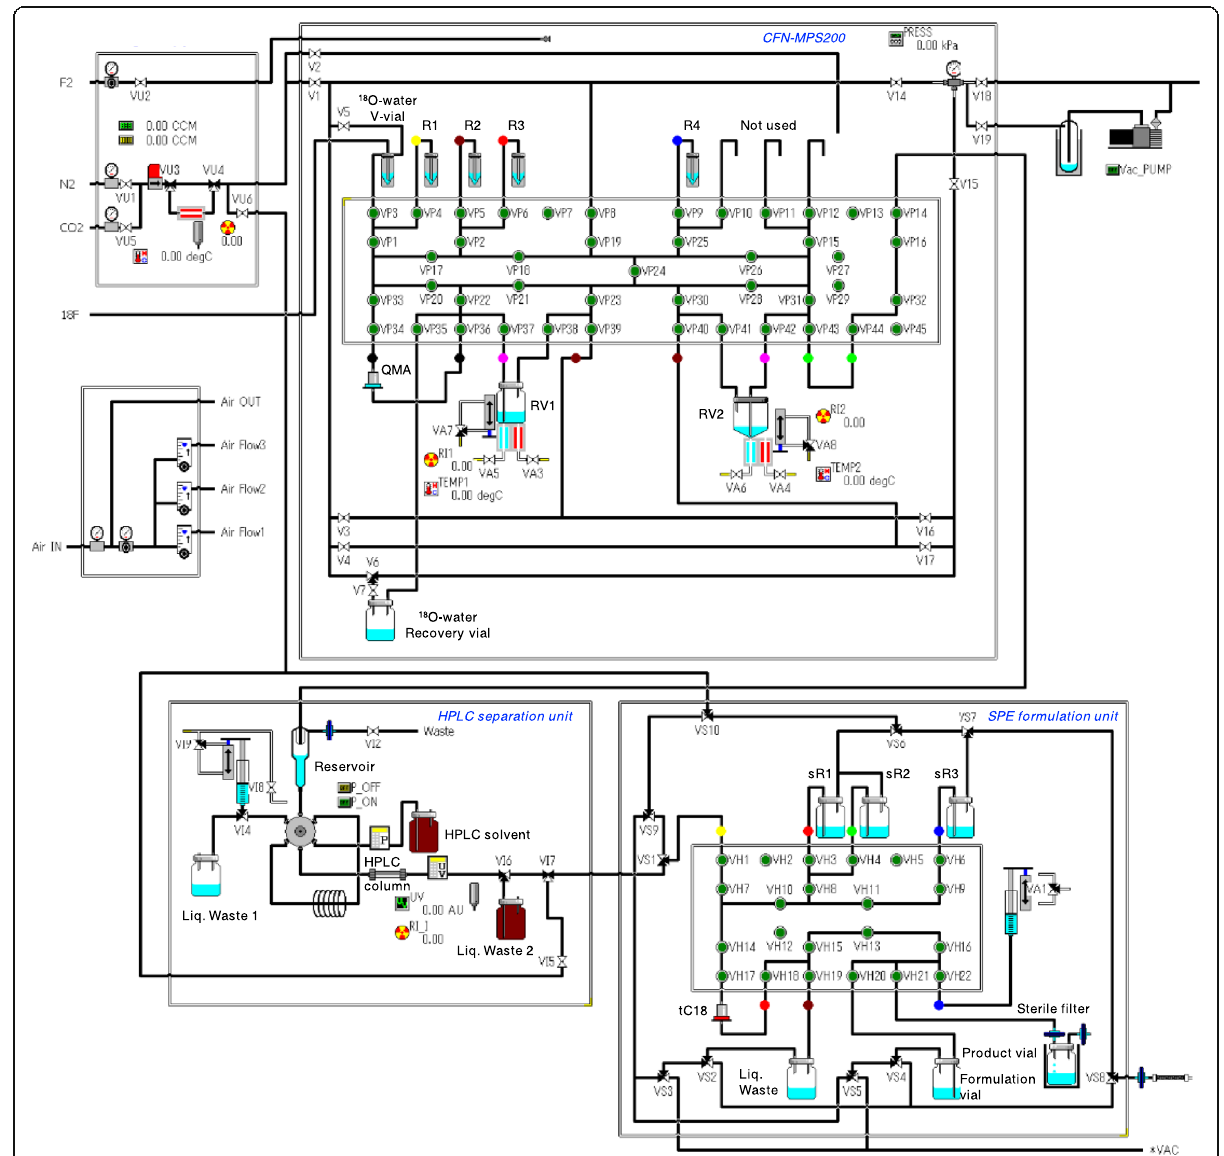
Fig. 1 Setup of the synthesis cassette, reagents, and vials for [ 18 F]MC225 production with integrated HPLC separation and SPE formulation